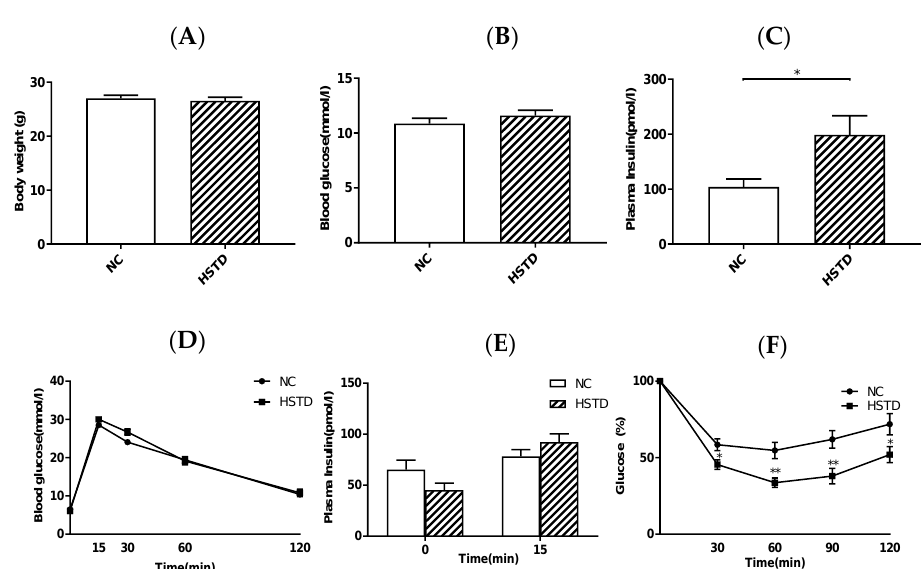
Figure 2. Body weight, metabolic parameters and evaluation of glucose tolerance and insulin sensitivity 5 weeks after intervention of diet in mice. ( A ) Body weight, ( B ) blood glucose and ( C ) plasma insulin levels under ad libitum fed condition. NC-fed mice (white bar; n = 8); HSTD-fed mice (white hatched bar; n = 7) * p < 0.05 ( D ) Blood glucose levels and ( E ) plasma insulin levels during IPGTT in NC-fed mice (black circle and white bar; n = 11) and HSTD-fed mice (black square and white hatched bar; n = 11). ( F ) Blood glucose levels during ITT in comparison to 0 min in NC-fed mice (black circle; n = 12) and HSTD-fed mice (black square; n = 9) (* p < 0.05, ** p < 0.01 compared to NC at indicated time). Statistical comparisons were done by unpaired Student’s t test in ( A – C ) and multiple t tests in ( D – F ). Correction for multiple comparisons was performed by using the Holm- Šidák method. Data represent means ± SEM.